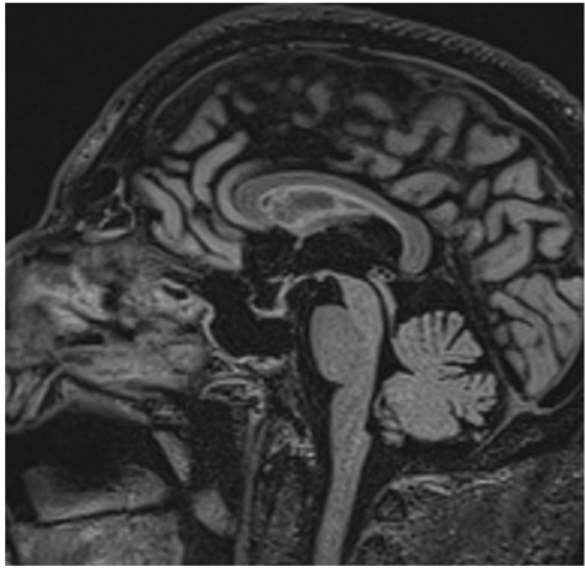
Figure 2. Partial “empty sellae syndrome” on brain MRI coronal section.